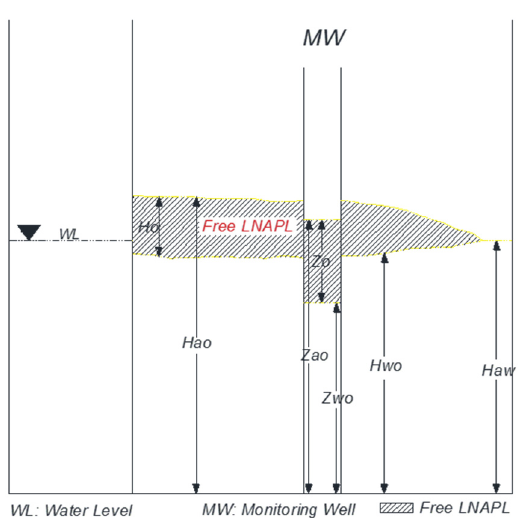
Figure 2. Abbreviations used for elevations and thicknesses of LNAPL and fluid interfaces, where Ho is the thickness of LNAPL contamination in the subsurface, Hao is the elevation of the air-LNAPL interfaces in the subsurface above a datum, How is the elevation of the LNAPL-water interfaces in the subsurface above a datum, Haw is the elevation of the water table above a datum, Zo is the LNAPL thickness in a monitoring well, Zao is the elevation of the air-LNAPL interface in a monitoring well above a datum, Zow is the elevation of the LNAPL-water interface in a monitoring well above a datum.